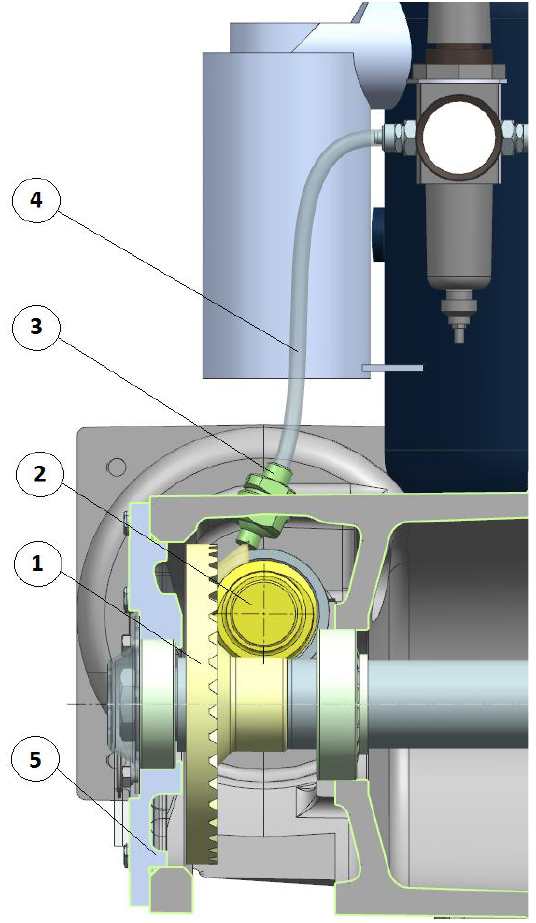
Figure 7. Spray (pressure) lubrication using spray nozzle. 1 — face gear, 2 — worm, 3 — spray nozzle, 4 — lubricant tube, and 5 — casing.